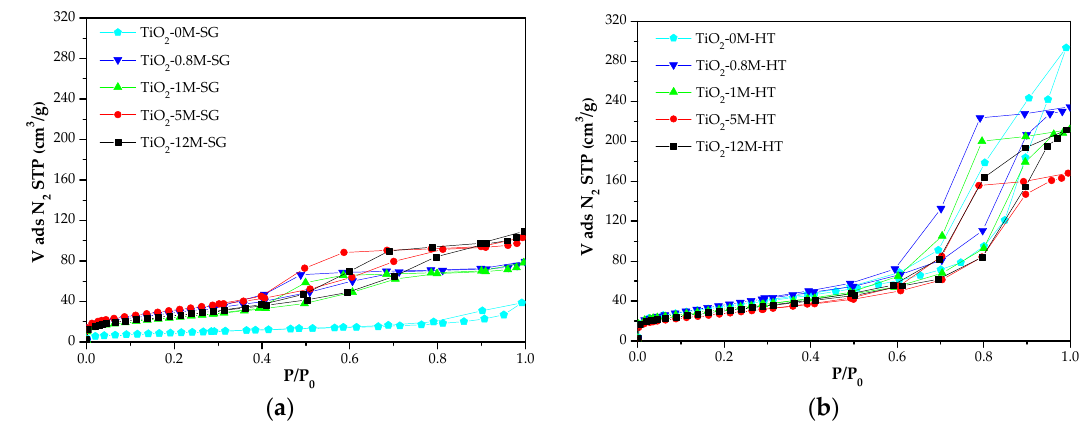
Figure 3. N 2 adsorption-desorption isotherms at − 196 °C of samples: ( a ) TiO 2 -XM-SG and ( b ) TiO 2 -XM-HT.